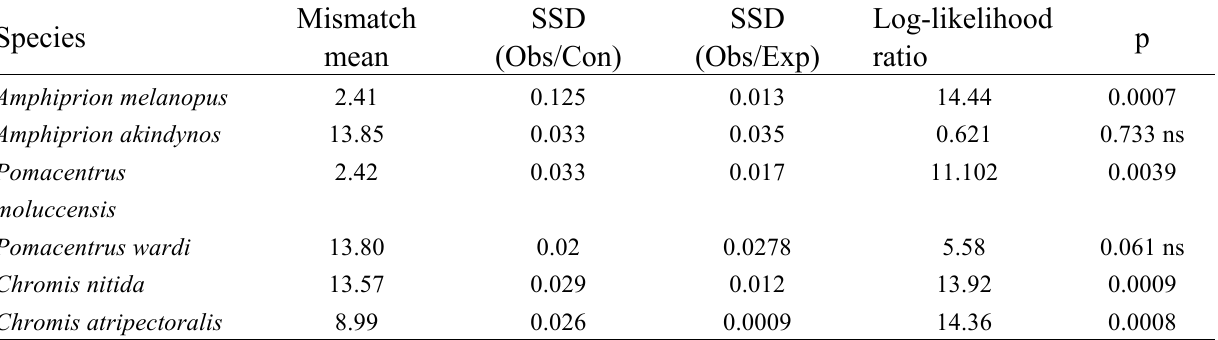
Table 3. Demographic history analysis of all species including mismatch mean, summed square deviations (SSD) between the observed, constant and expected population models, log-likelihood ratio tests and Bonferroni corrected p (sequential Bonferroni correction, α = 0.008; ns = not